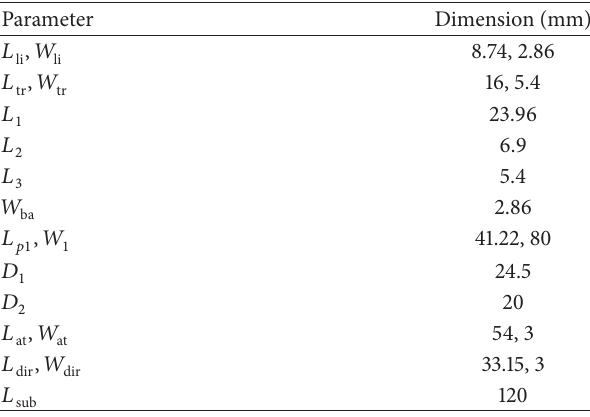
Figure 2: The prototype of the Quasi-Yagi antenna designed and used in this work. Table 1: Parameters dimensions of the Quasi-Yagi